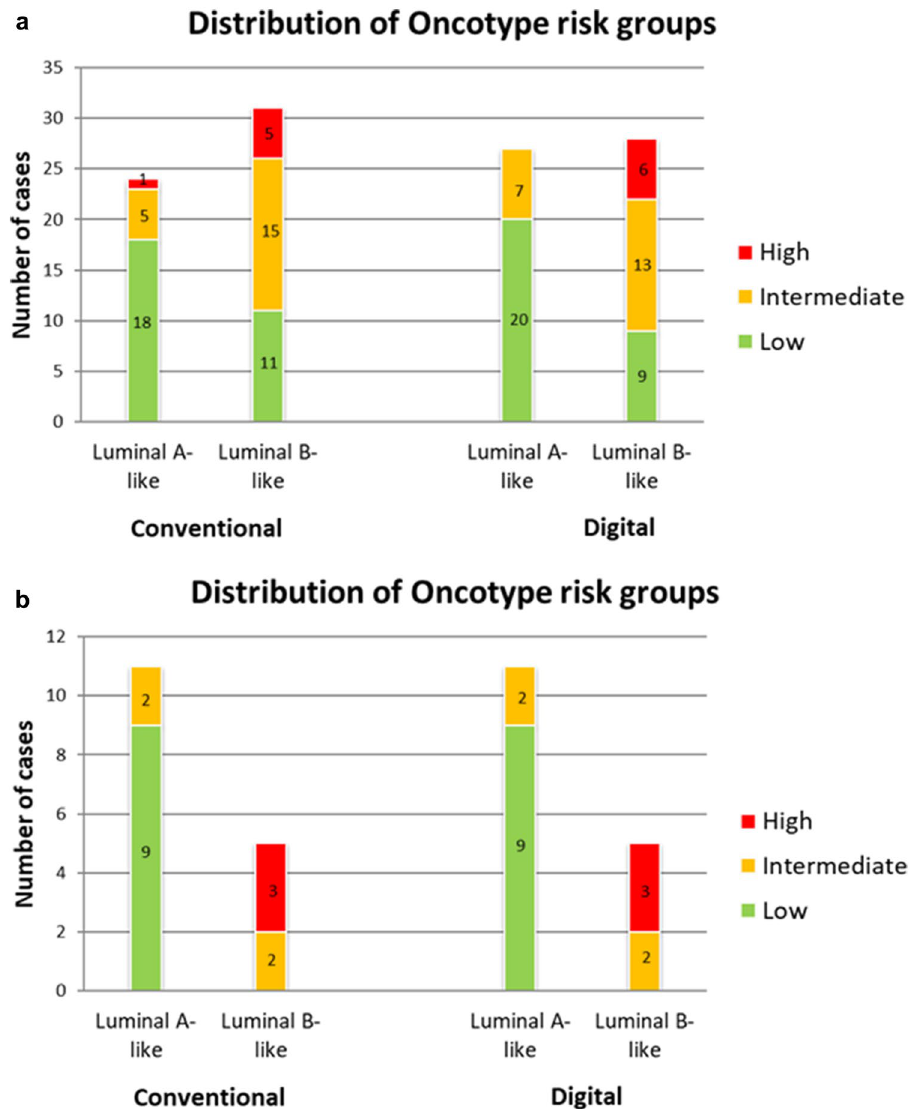
Figure 2. Distribution of the Oncotype DX risk groups within the surrogate subtypes derived from conventional and digital methods of Ki67 quantification, showing the classification into surrogate subtypes by conventional and digital methods using Ki67 mean as cut-off point ( A ) and Ki67 mean-SD and mean + SD discarding the grey zone ( B